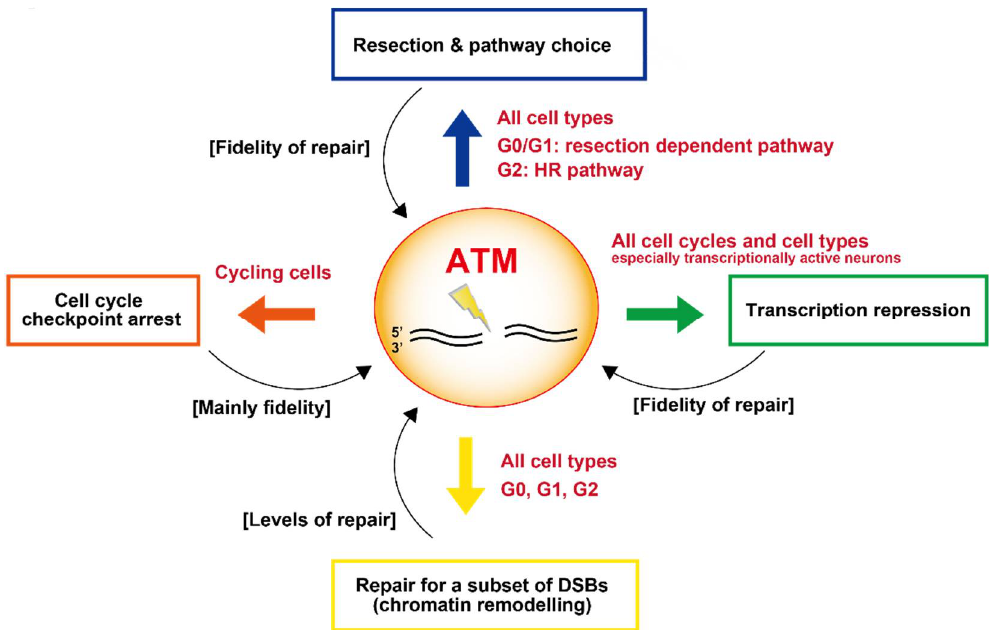
Figure 5. Summary highlighting the 4 pathways discussed in the text by which ATM influences the repair of DSBs. The impact on the level or fidelity of DSB repair in each pathway is shown by brackets; the type of cell affected is highlighted in red. Additional impacts of ATM, such as its role in regulating apoptosis, may also influence survival levels in response to DSBs but here we focus on pathways that influence DSB repair.